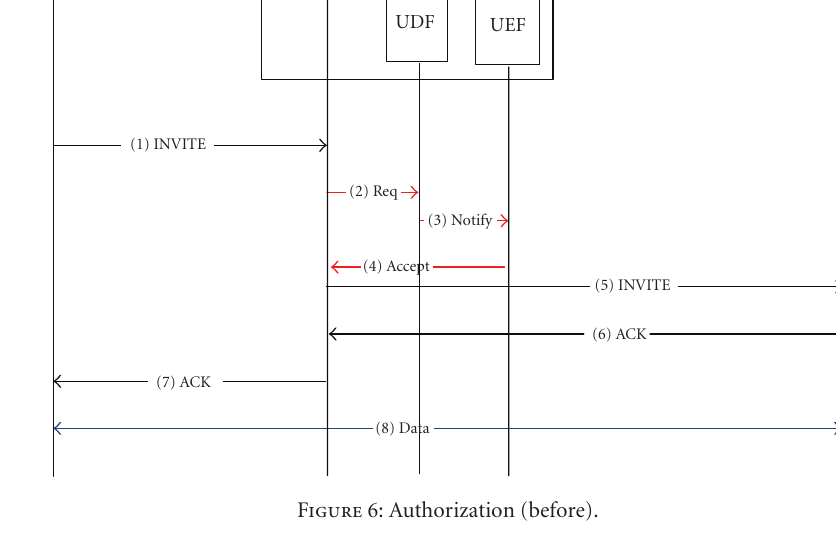
Figure 6: Authorization (before).